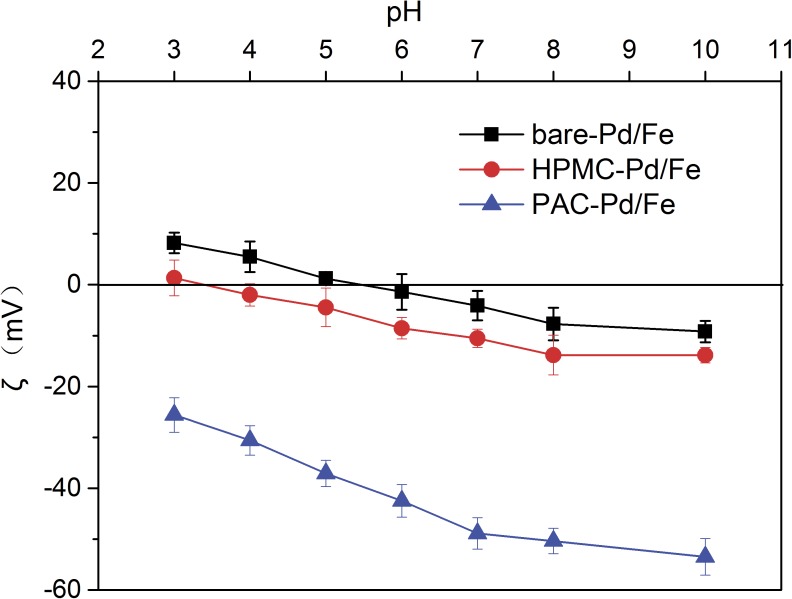
Zeta (ζ) potentials of bare-Pd/Fe, HPMC-Pd/Fe, and PAC-Pd/Fe NPs as a function of solution pH.Fe concentration is 0.4 g L-1 with Pd 0.3 wt% of Fe, HPMC and PAC are 1 g L-1, respectively. Error bars represent the standard deviation of three samples.